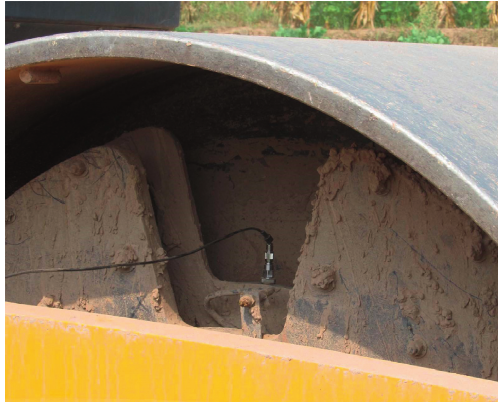
Figure 2: Installation of vibration